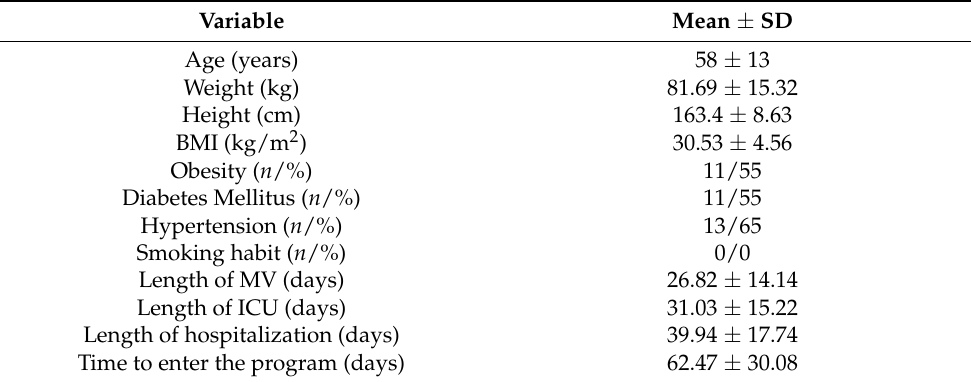
Table 2. Baseline characteristics of the participants. Variable